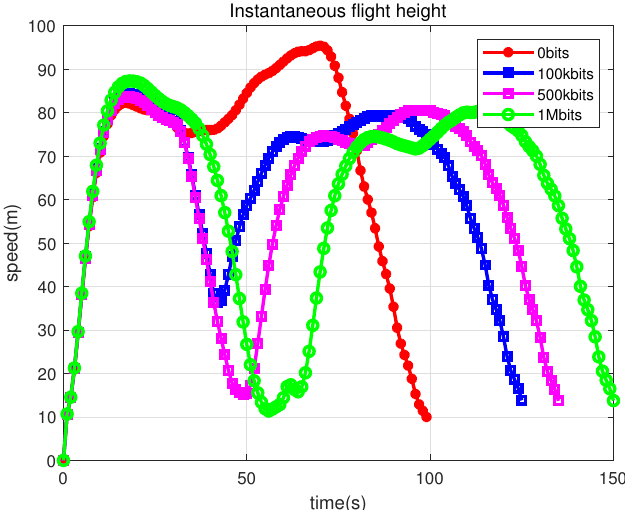
Figure 13. Instantaneous flight speed variation.